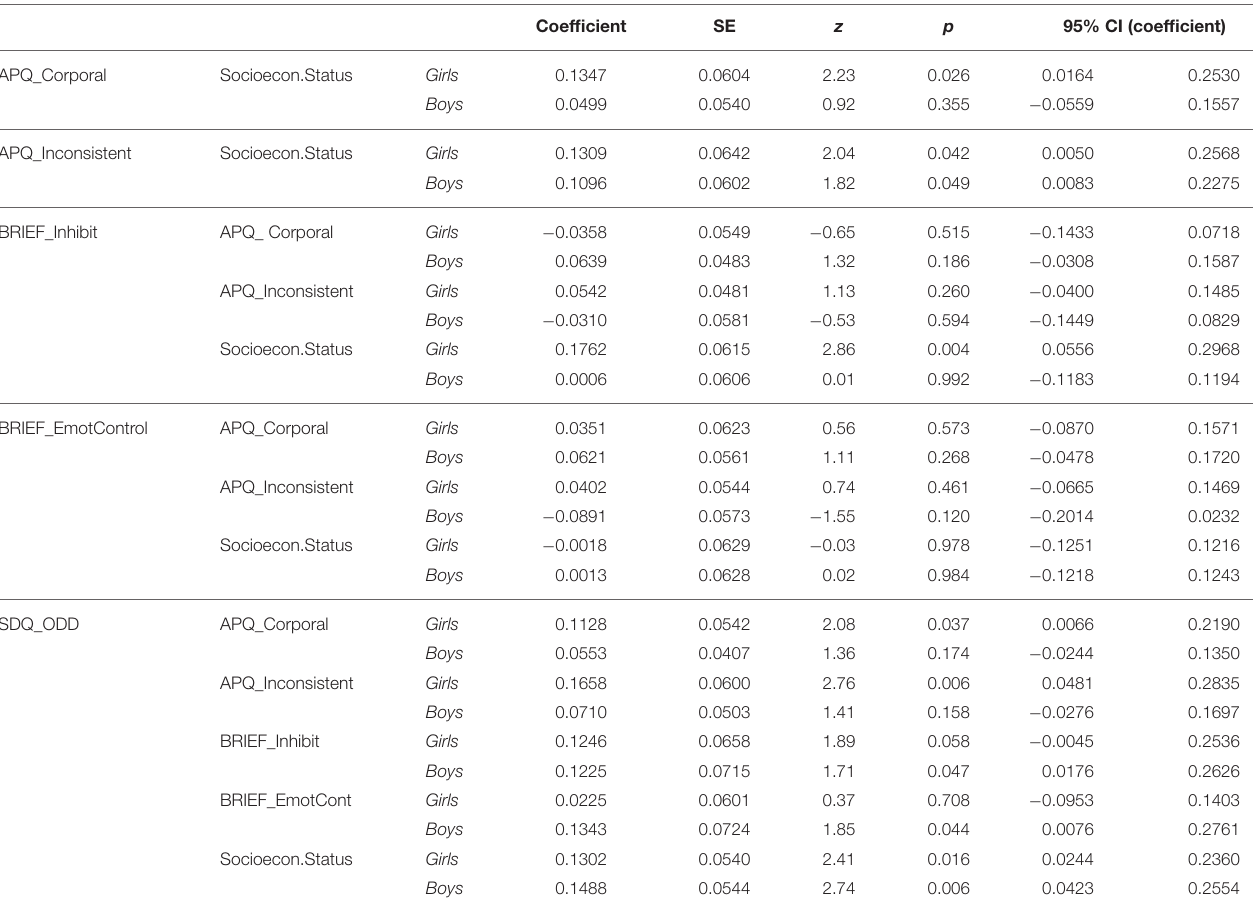
TABLE 3 | Structural coefficients of the final SEM diagram ( N = 604 ). Coefficient SE z p 95% CI